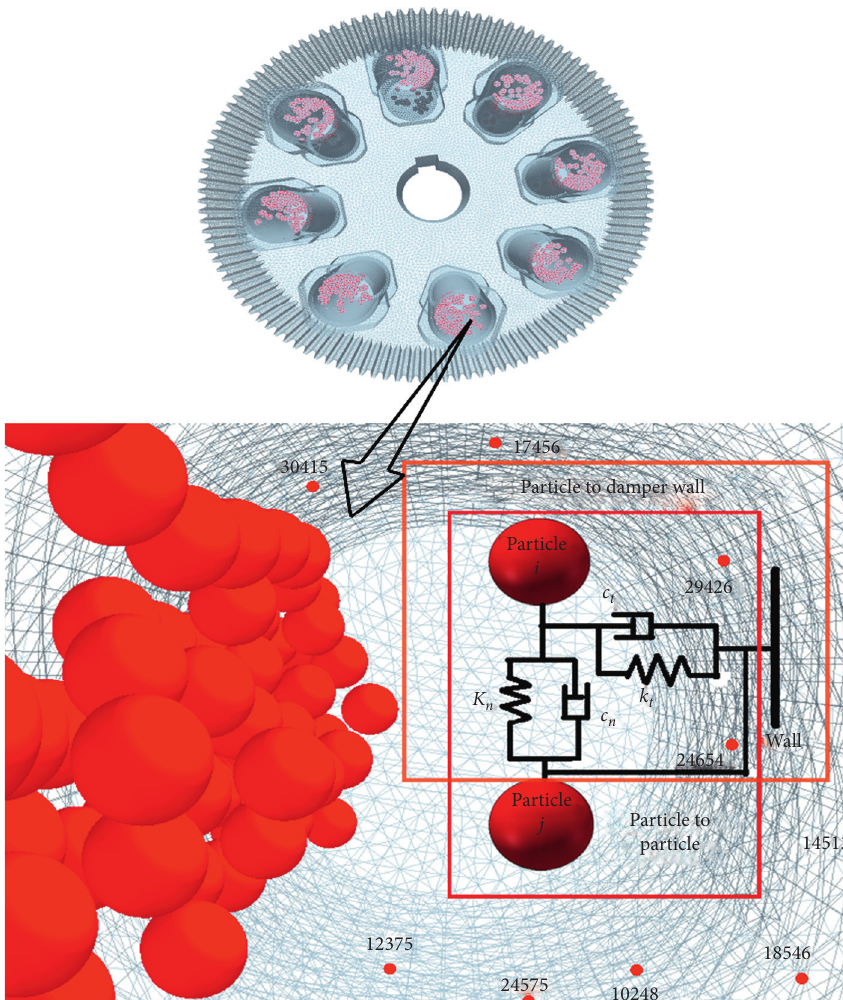
Figure 4: Gear model equipped with particle